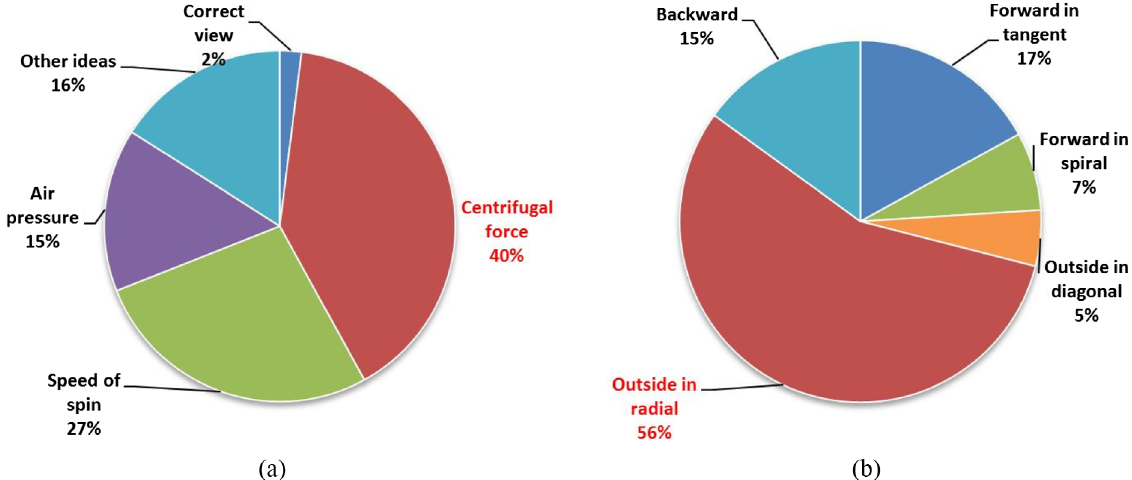
FIG. 3. (a) (left) Distribution of responses regarding the question: Why did the water not spill out? (b) (right) Distribution of responses regarding the question “ If the rope holding the bowl suddenly tears, at what trajectory will the bowl fly?